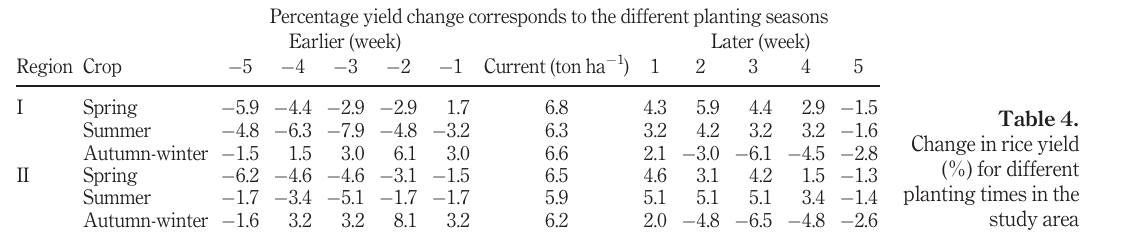
Figure 4. Results of the model validation based on the simulated and observed yield of a) spring, b) summer and c) autumn – winter planting seasons in subregion I; and d) spring, e) summer and f) autumn – winter planting seasons in subregion II